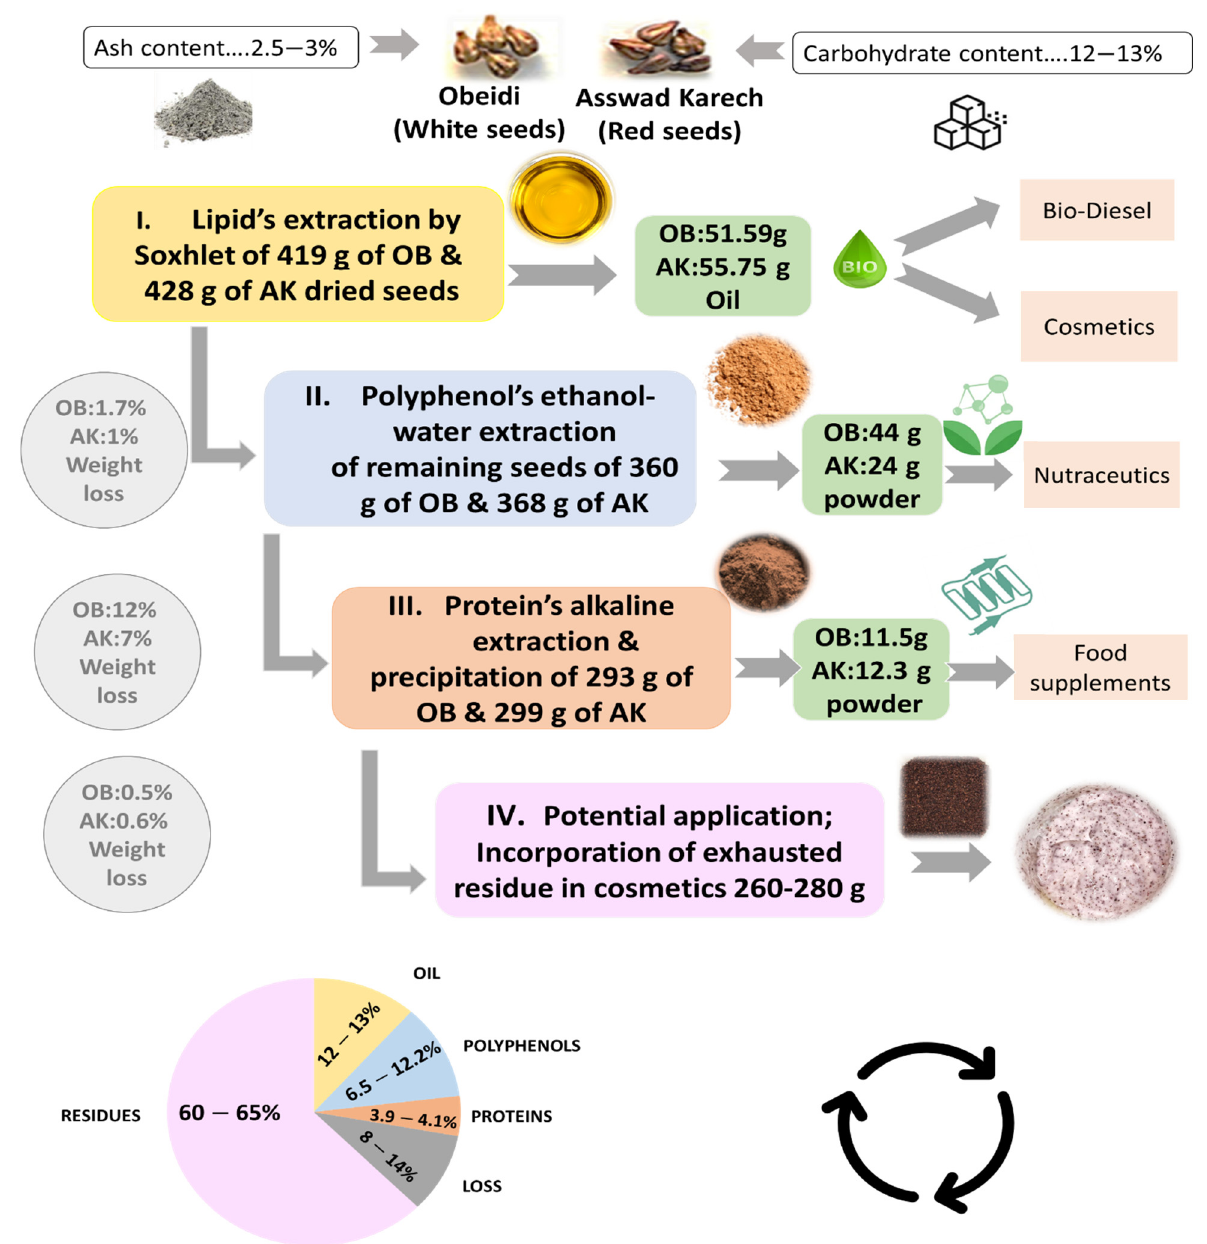
Figure 5. Schematic overview of a multi-step valorization of grape pomace seeds from Asswad Karech (AK) and Obeidi (OB).